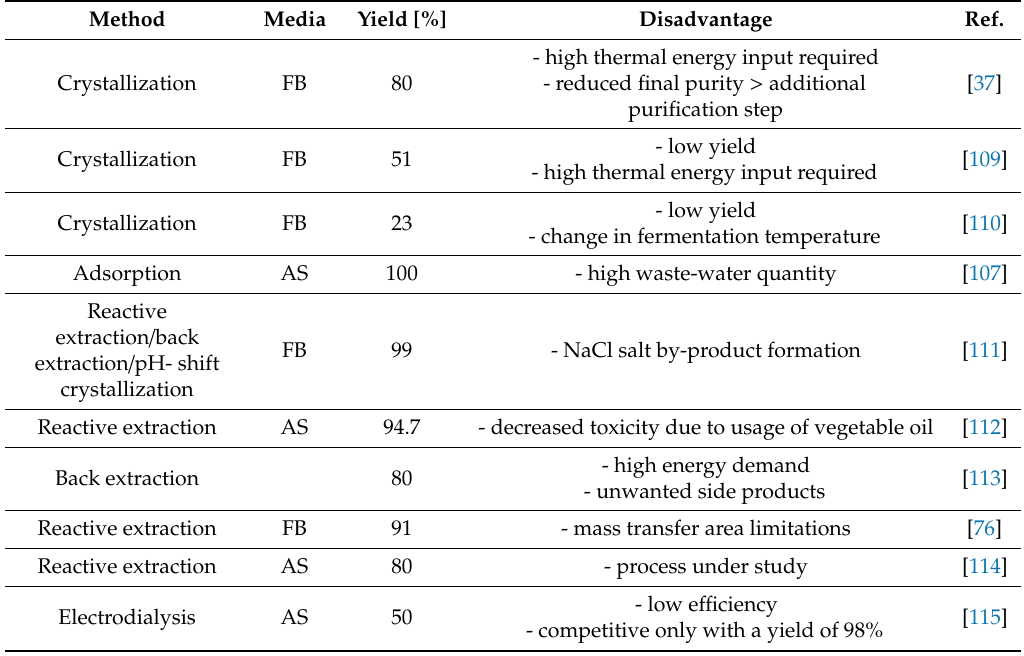
Table 3. IA recovery method examples and main process